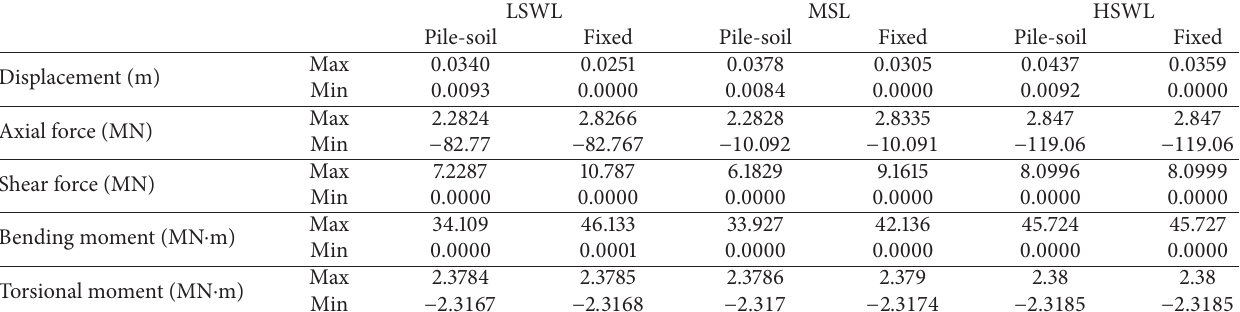
Table 14: Structural results under irregular wave condition.